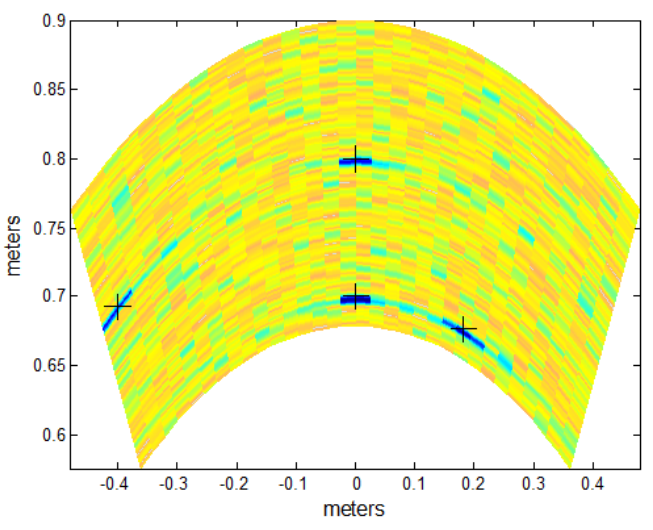
Figure 10. Several reflectors location estimation with Encoded